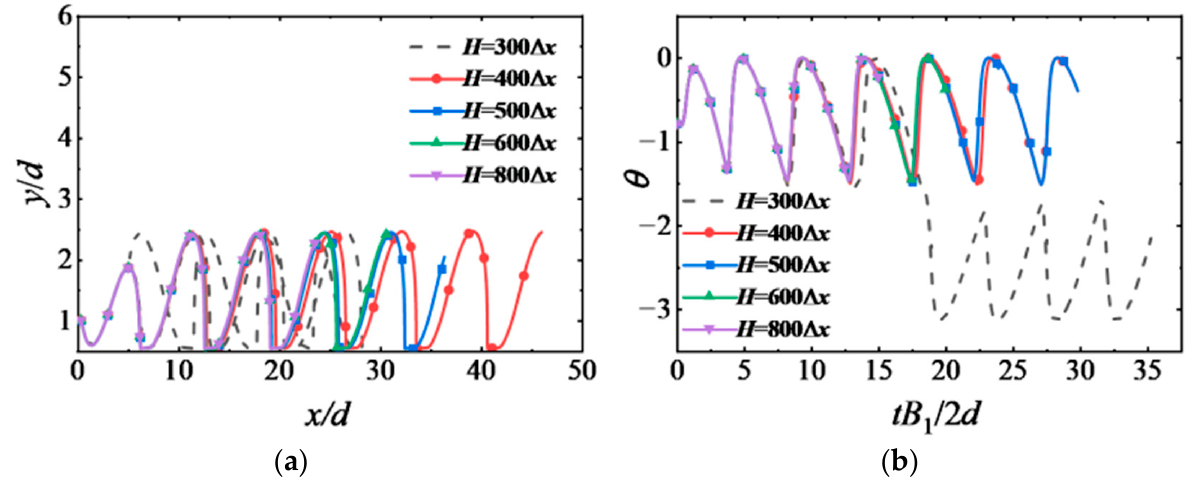
Figure 2. Trajectory and variation in the orientation with time for a rod-shaped squirmer with β = 3 at Re s = 0.5 (initial angle θ = −π /4, h = d ): ( a ) trajectory and ( b ) orientation.